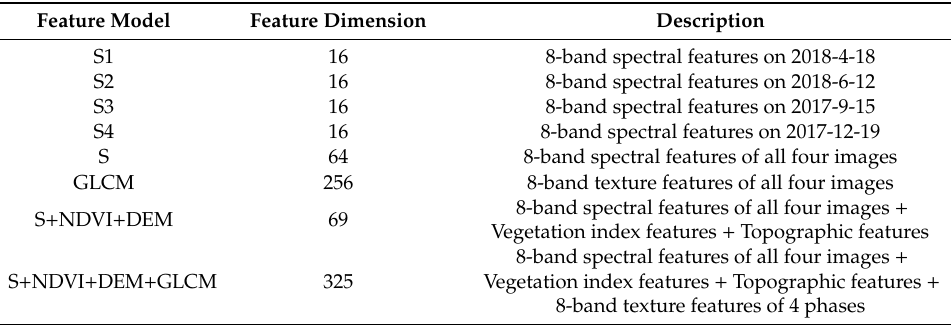
Table 2. Eight groups of feature models used for accuracy analysis.